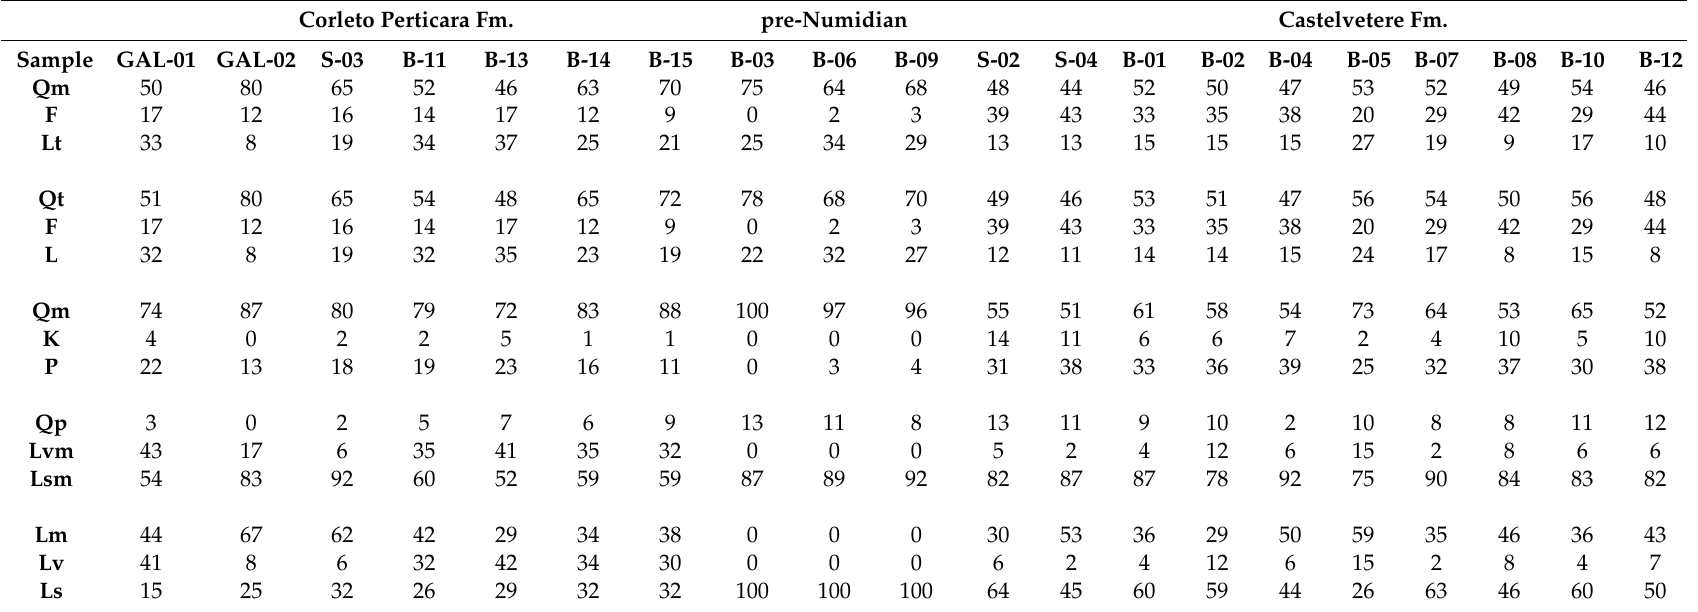
Table 4. Recalculated modal point for collected samples (X = mean SD = standard deviation). Grain parameters: Qm = monocrystalline quartz; Qp =